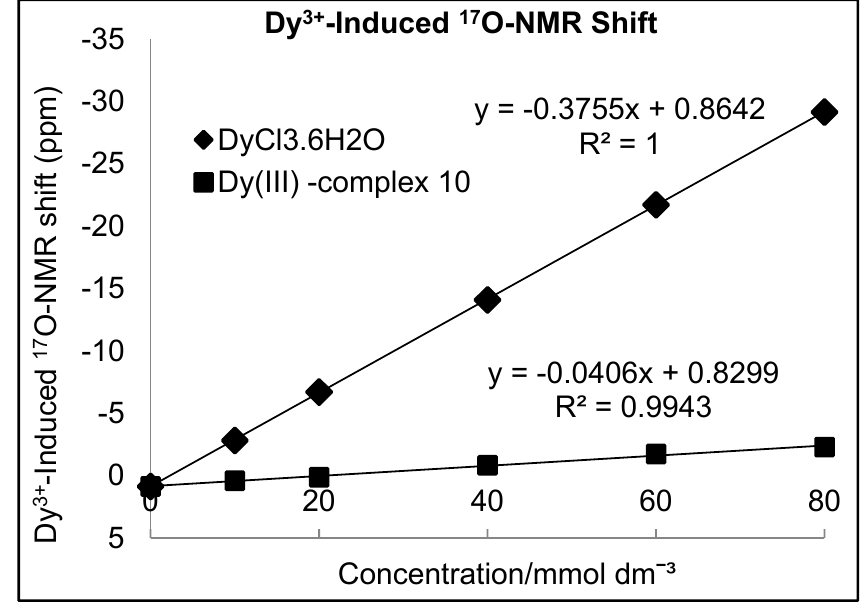
Figure 2. Plot of the Dy 3+ -induced water 17 O-NMR shift as a function of